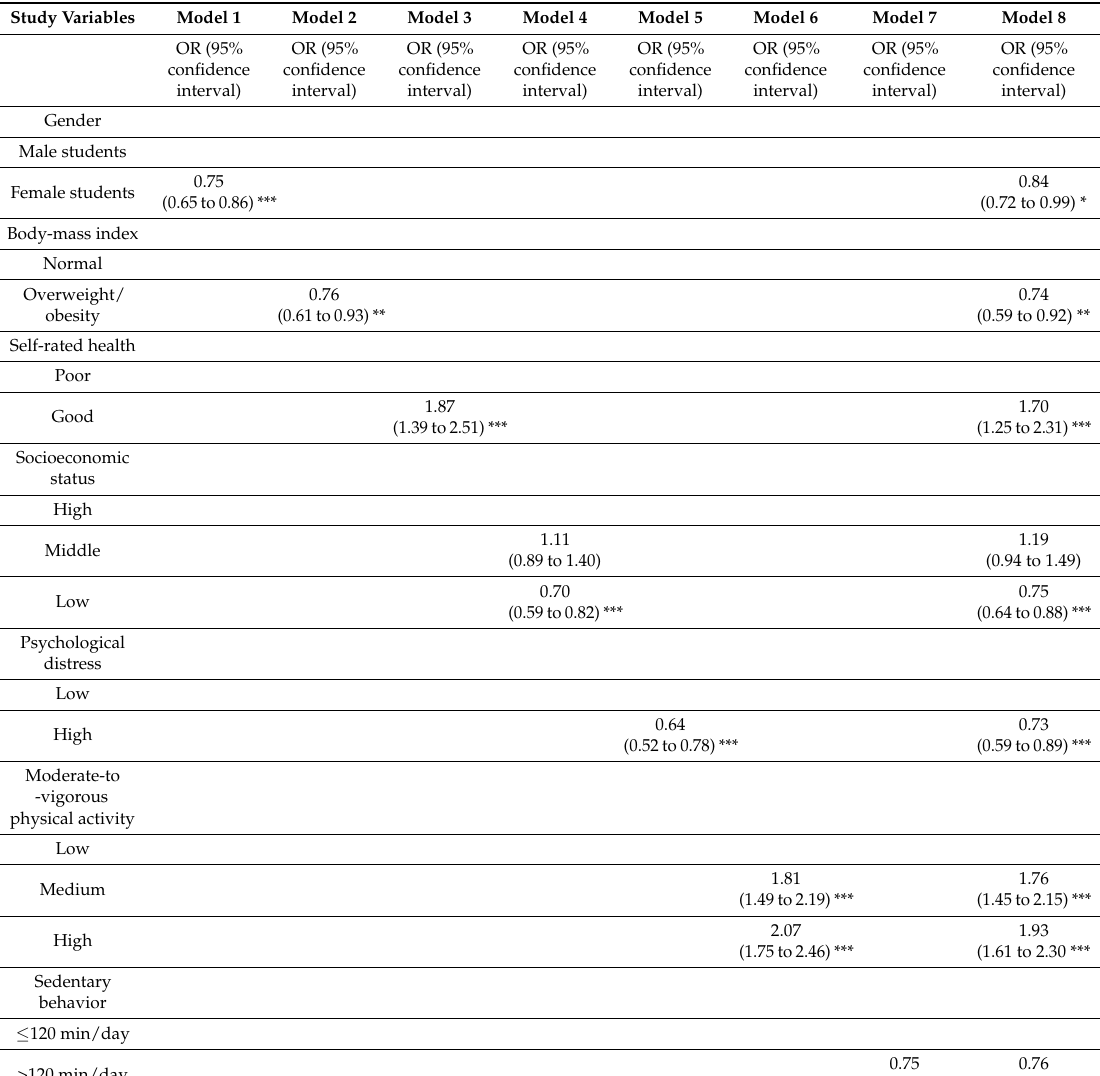
Table 2. Odds ratios (ORs) for average/good adherencega Mediterranean